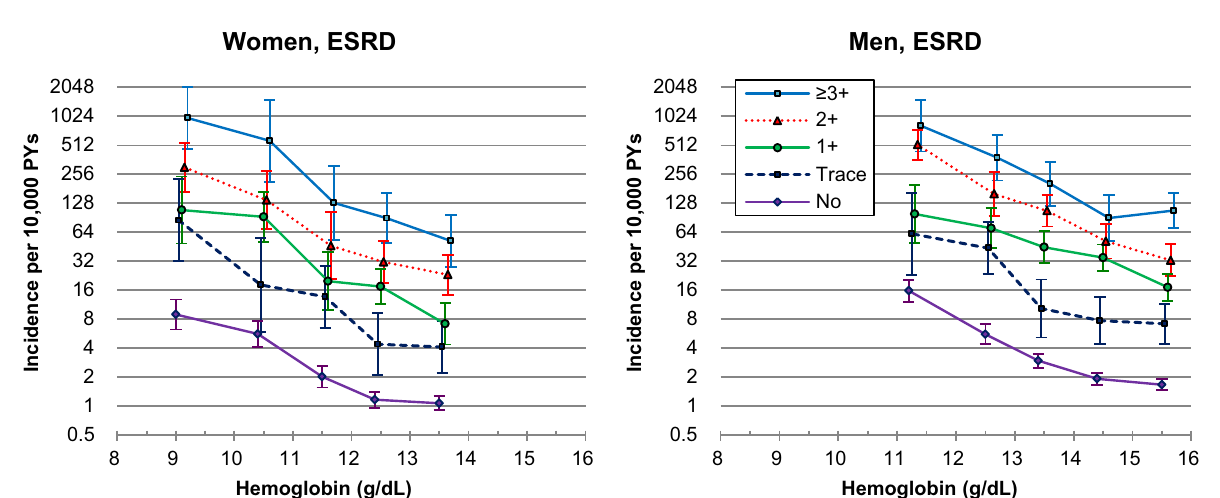
Fig 1. Age-adjusted � incidence of end-stage renal disease (ESRD) in 25 combined hemoglobin and albuminuria groups in women and men. � Poisson regression was used.